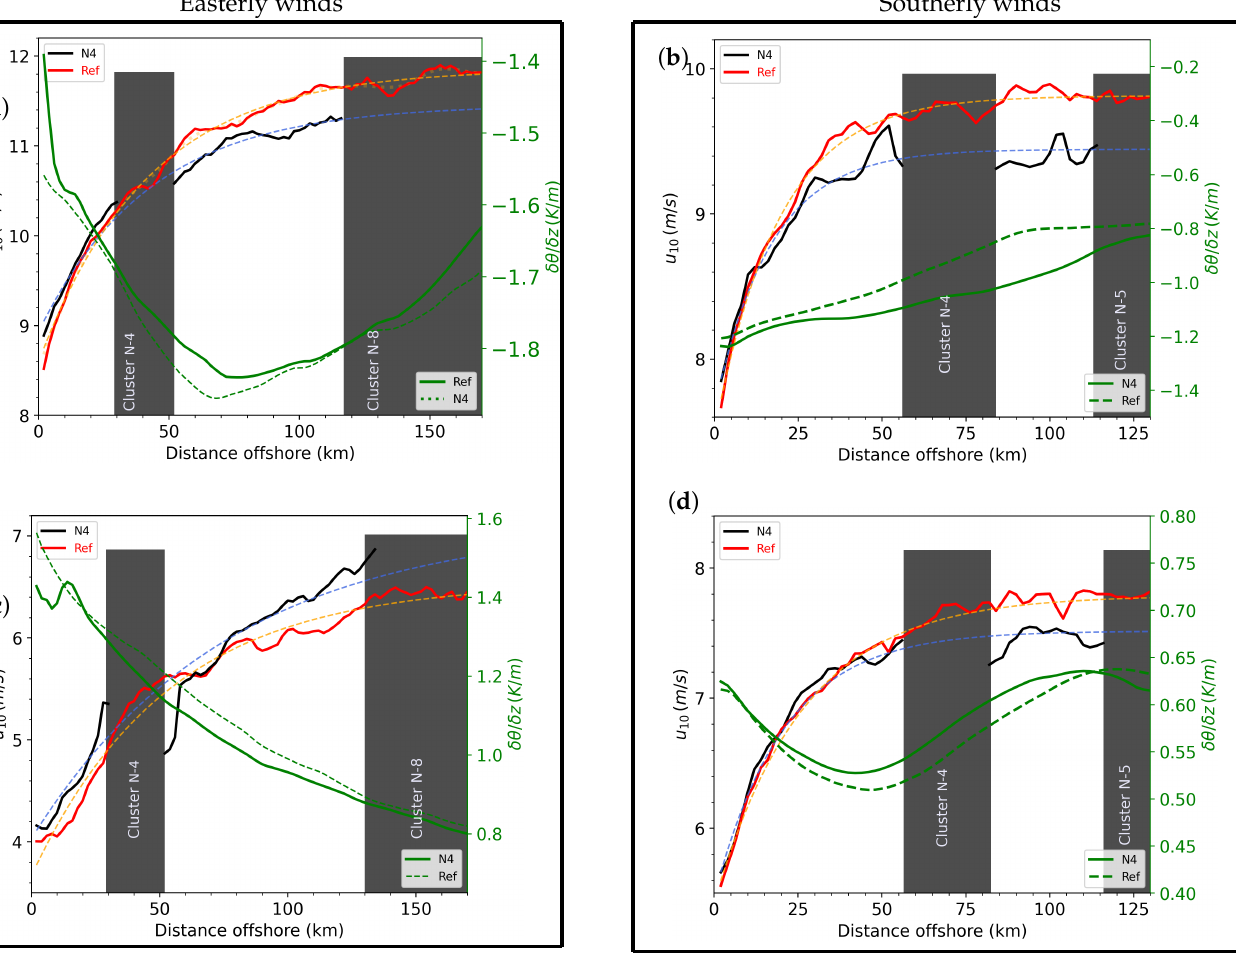
Figure 14. ( a , b ): Average wind speed gradients for the “INCS” class from unstable cases for easterly ( a ) and southerly ( b ) wind directions. ( c , d ): The same as ( a , b ) from stable conditions. These curves refer to the horizontally and vertically oriented rectangles shown in Figure 2b passing through cluster N-4 (black line, “N4”) and void of windfarms (red line, “Ref”) for, respectively, easterly and southerly winds. Green curves correspond to thermal stability for the “N4” transect (solid line) and the “Ref” transect (dashed line). The blue and orange dashed lines refer to the fitted empirical